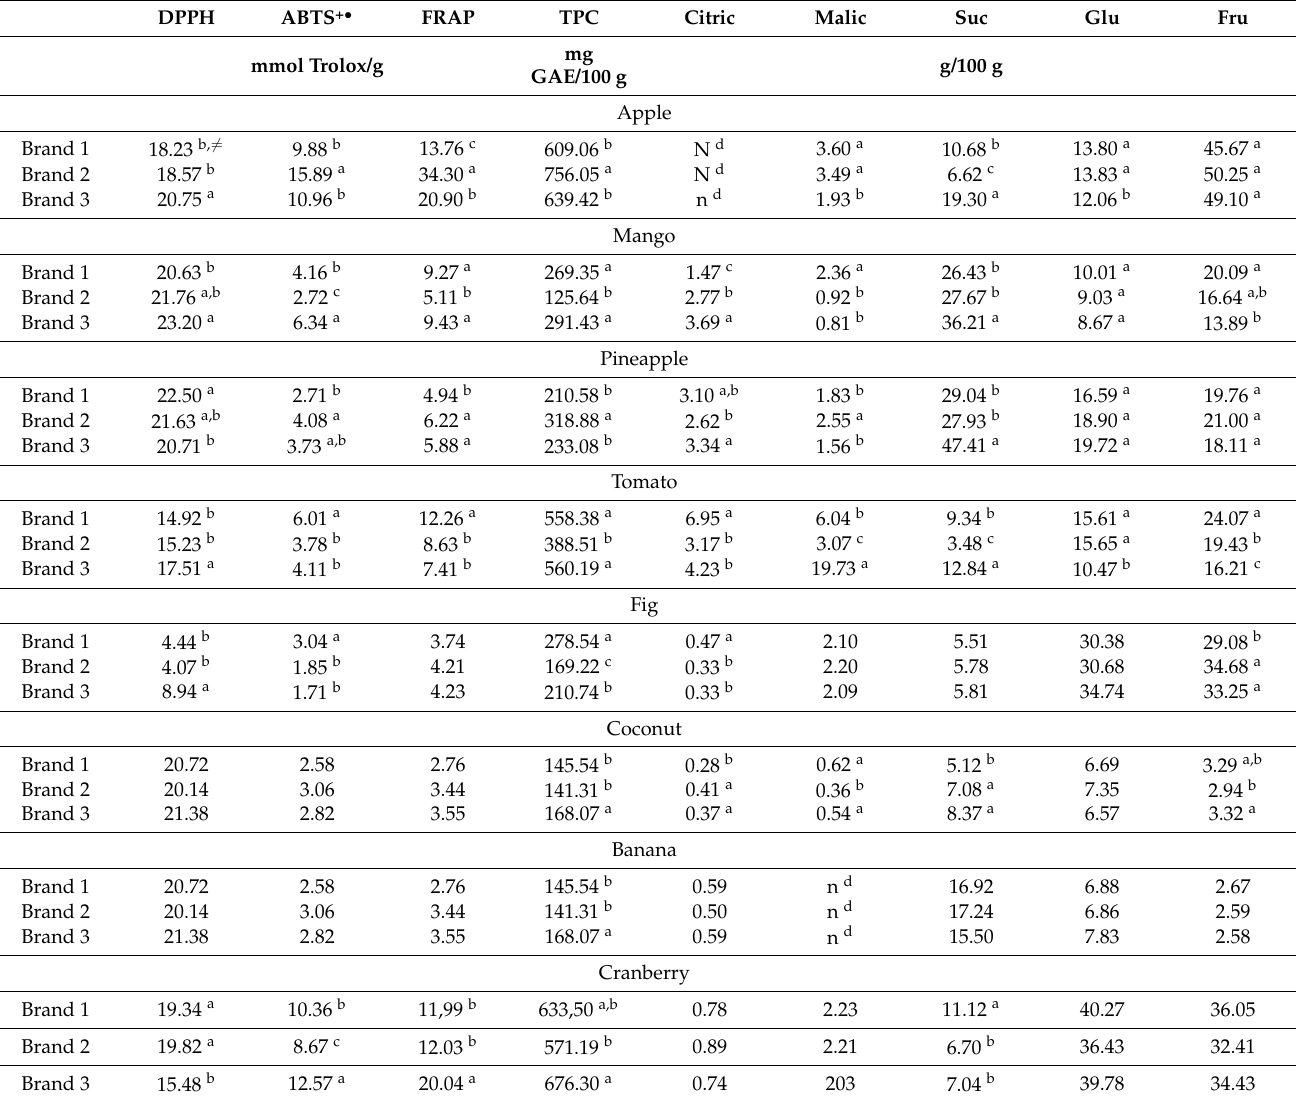
Table 4. Antioxidant capacity, total phenols, and organic and sugar